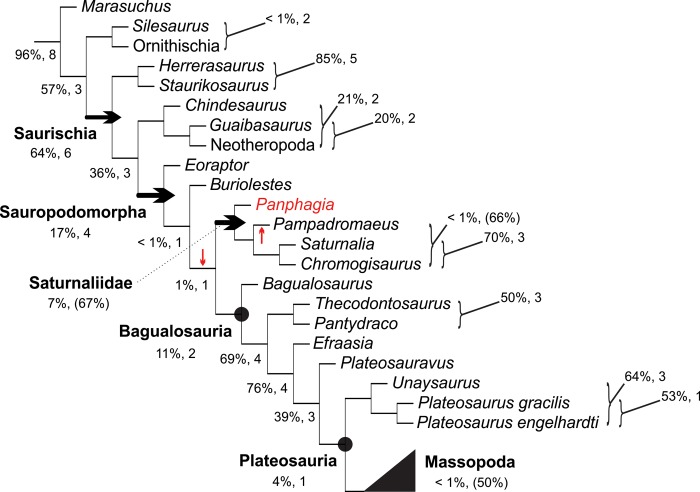
Phylogenetic position of Pampadromaeus barberenai.Abridged version of the “majority-rule” consensus of 192 MPTs recovered in the present phylogenetic analysis, depicting the position of Pam. barberenai. Circles and horizontal-black arrows indicate node- and branch-based clade names, respectively. Vertical-red arrows indicate the alternative positions for Pan. protos found in a IterPCR analysis. CG bootstrap values are indicated for each clade followed by either “Bremer support” values, for clades present in all MPTs, or by the MPTs percentage (under brackets) in which the clade appears.